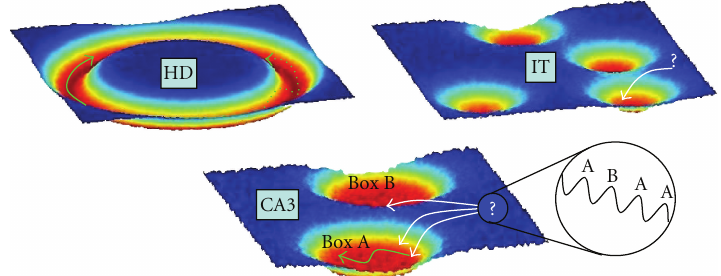
Figure 5: Di ff erent types of (idealized) attractors suggest distinct interpretations of neural dynamics observed in experiments. In the 1D ring attractor putatively underlying the head direction system [77] (top left), changing head direction implies moving, whether continuously (green arrow) or in jumps (dashed arrow), along the attractor. Convergent neural activity in IT [76] (top right) and rapid flickers in CA3 [73] (bottom) can be interpreted as rolling down into the attractor basin (white arrows). In CA3, spatial representation activity can also move along the flat attractor valley [79] (green